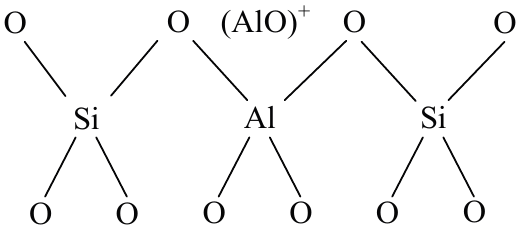
Figure 18. Framework structure of the acidity